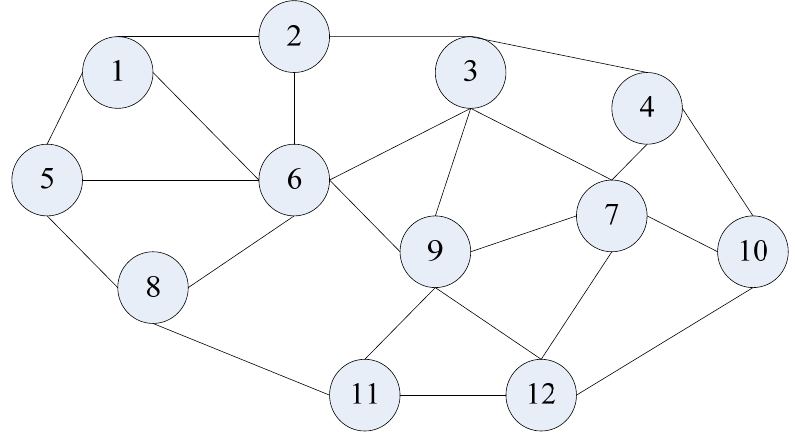
Figure 6. The layout of the simulated city.